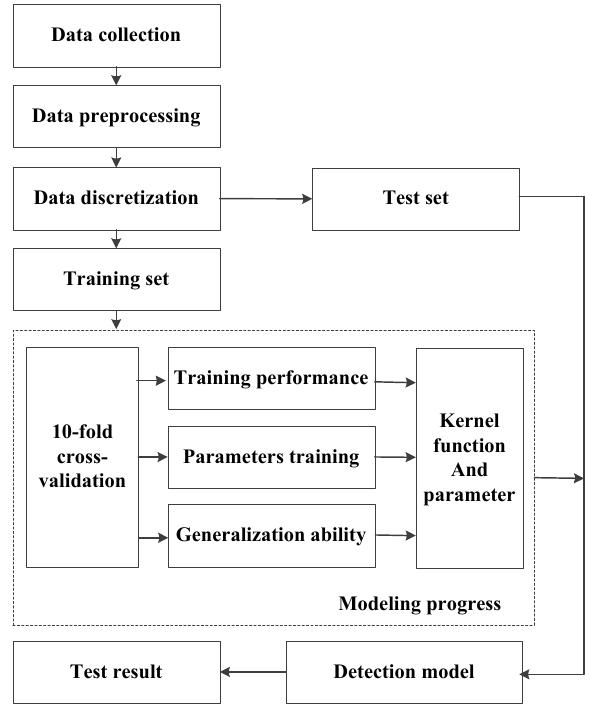
Figure 3. The SMO modeling process.